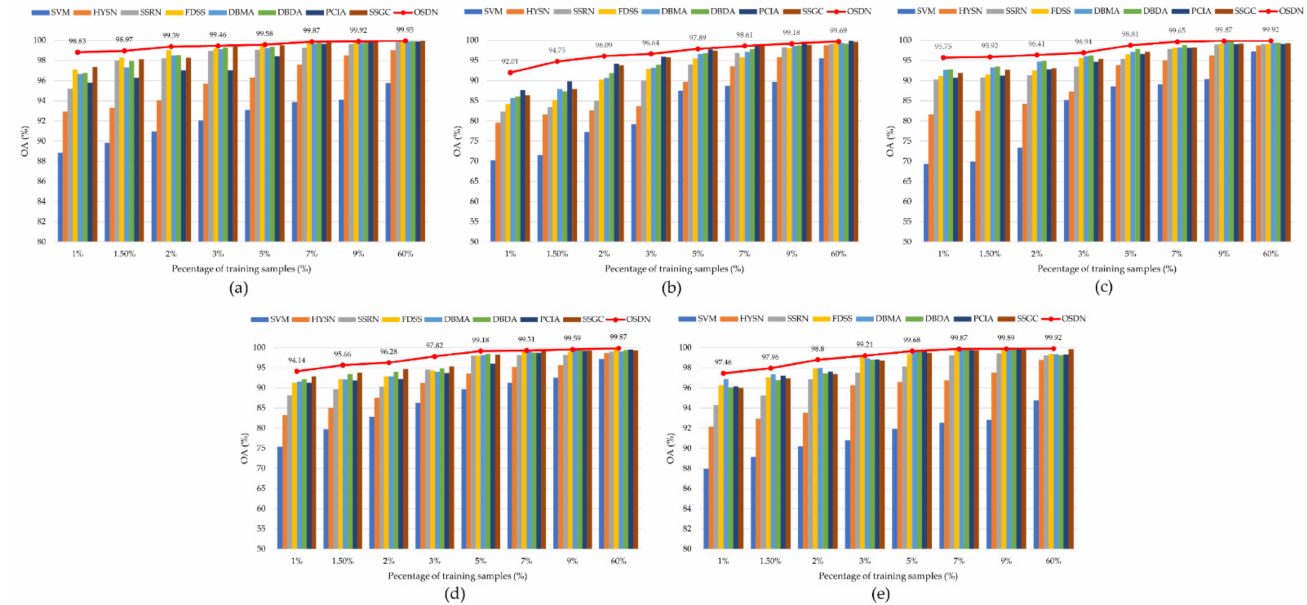
Figure 13. Comparison of OA using different training sample proportions for the five datasets: ( a ) PU, ( b ) KSC, ( c ) BS, ( d ) HS, and ( e )